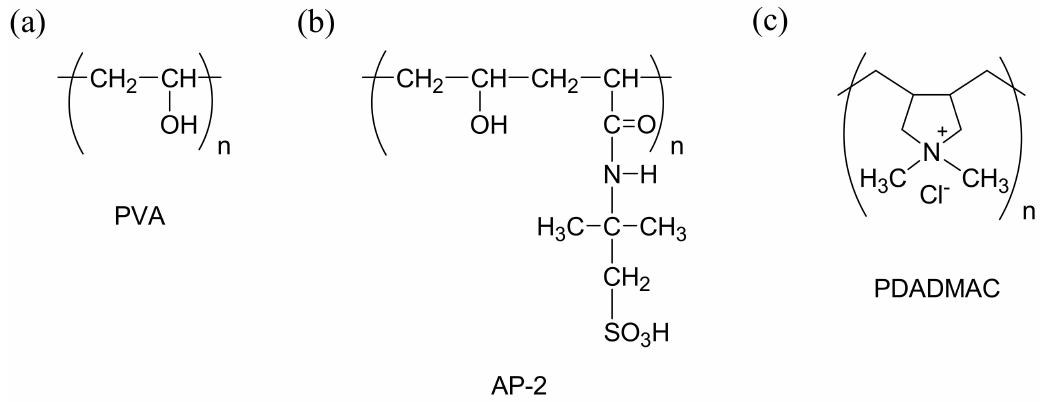
Figure 2. Chemical structure of ( a ) PVA, ( b ) AP-2, and ( c ) PDADMAC polymers used in this